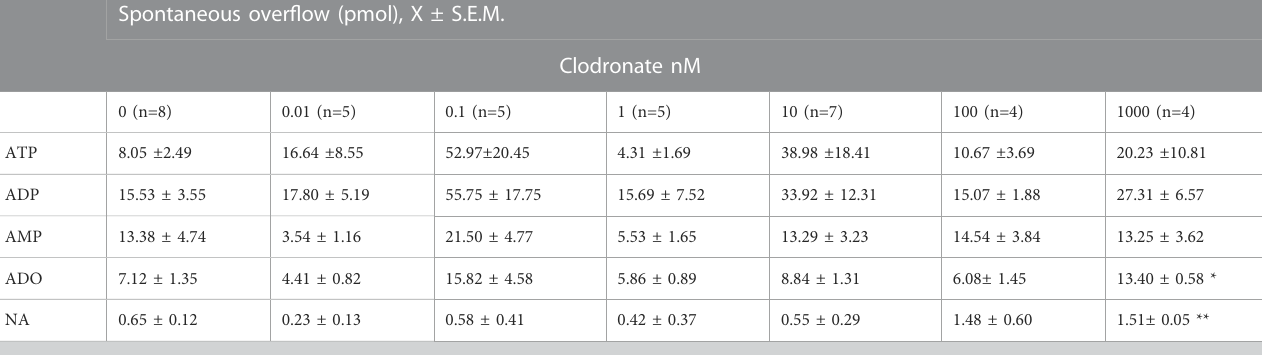
TABLE 1 Clodronate concentration-dependent effects on spontaneous and electrically evoked ATP/metabolites and NA over fl ow from the mesentery neuroeffector junction. Spontaneous over fl ow (pmol), X ±